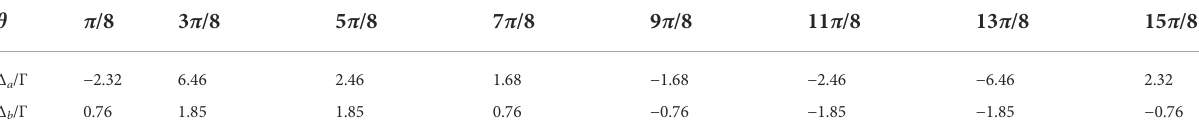
TABLE 2 The values of the parameters θ , Δ a and Δ b with T n = R n = 0.5 and T m = R m = 0 in Figure 7.